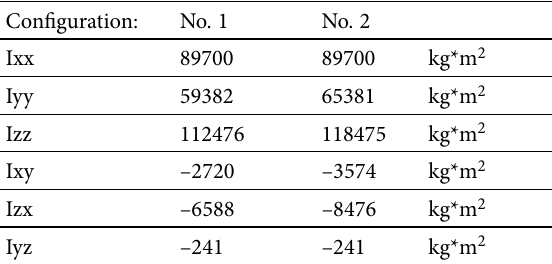
Table 2. Moment of inertia for both configurations